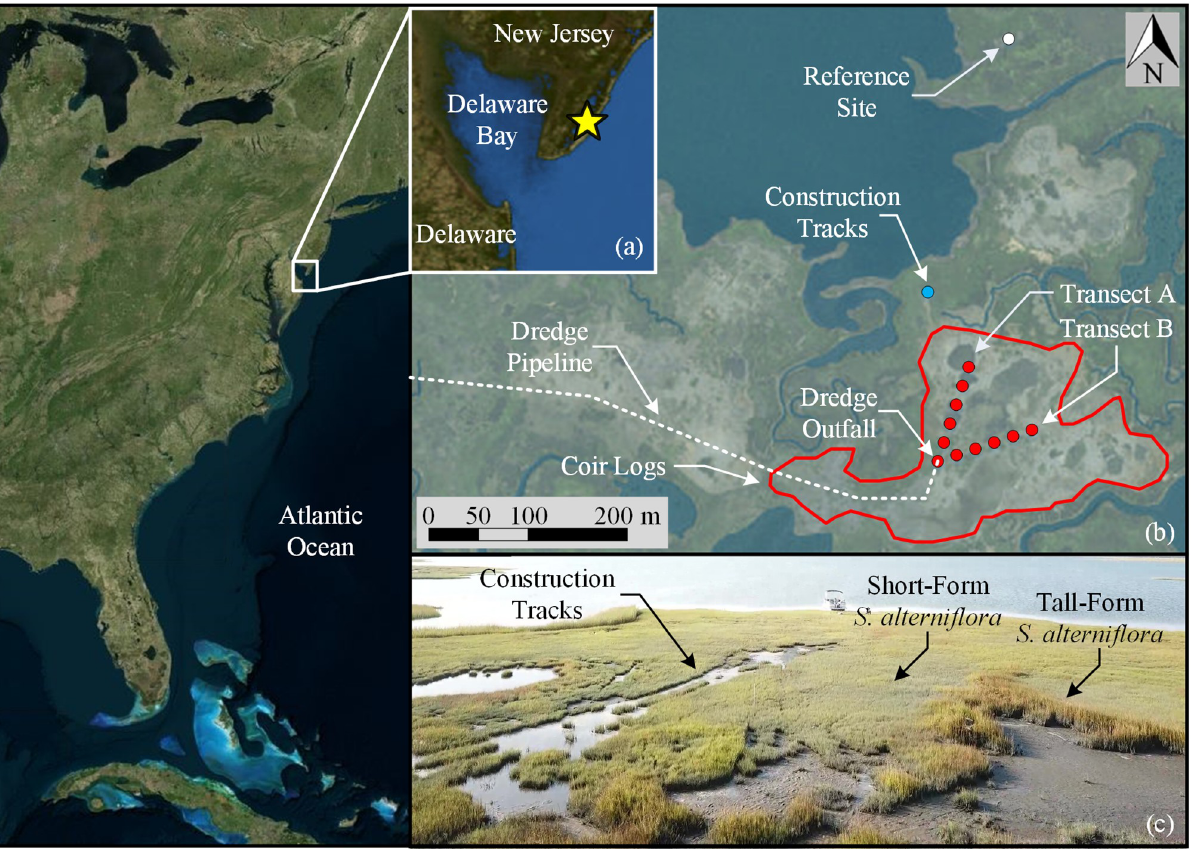
Fig 1. Overview of sediment nourishment study site in Avalon, New Jersey, USA. (a) Location of the study site. (b) Investigation layout, coir log containment, dredged outfall, and pipeline locations. Aerial images from The National Map Orthoimagery courtesy of the U.S. Geological Survey (2020). (c) An image showing tall- and short-forms of S . alterniflora . Image taken by author.